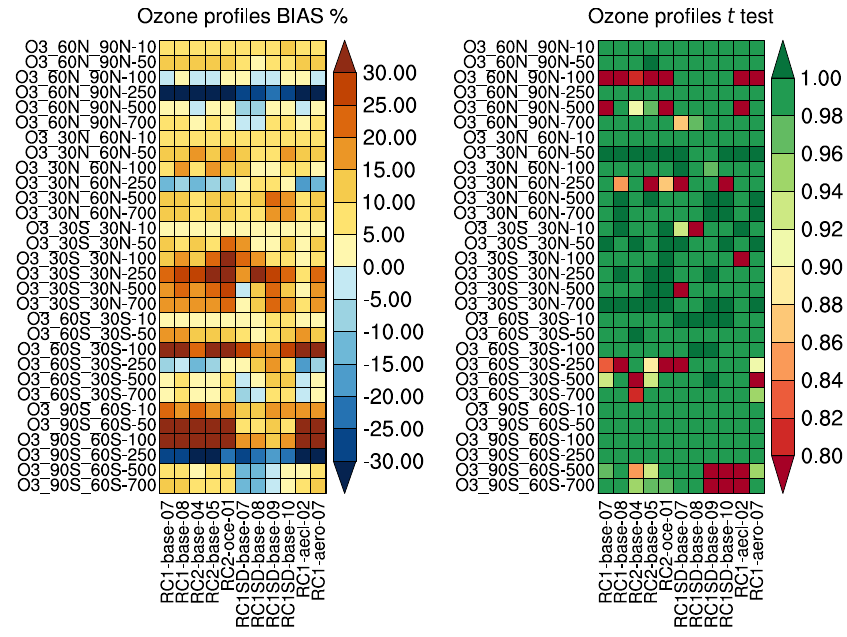
Figure 31. Same as Fig. 26, but for the ozone volume mixing ratio at 6 selected pressure levels (700, 500, 250, 100, 50, 10hPa). The ozone sonde data set (Tilmes et al., 2012) is used as reference. All tiles are based on the annual cycle, calculated from monthly data of the years 1995 to 2011. Results of a paired t test for the probability to reject the null hypothesis of equal means is shown on the